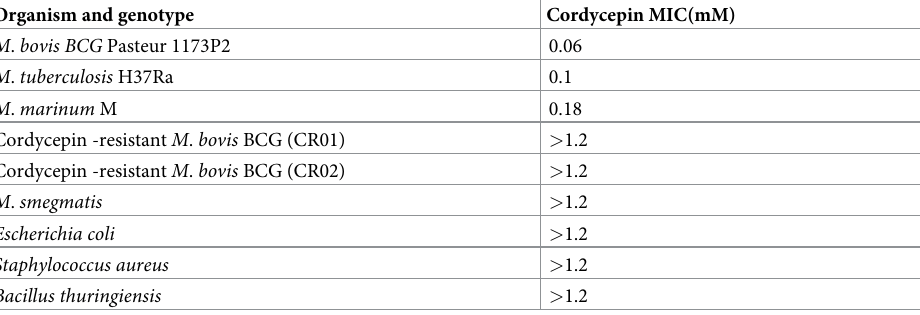
Table 1. MIC determination of cordycepin against selected microorganisms. Organism and